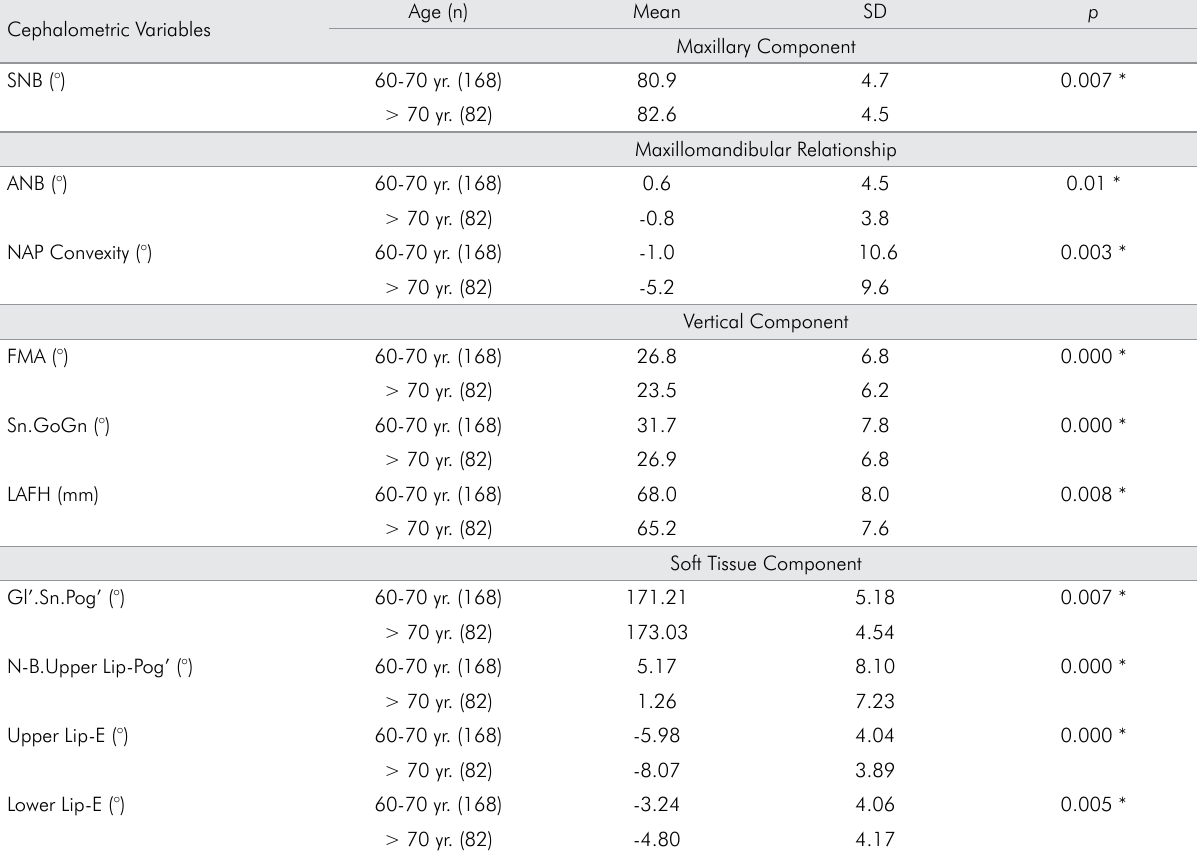
Table 4. Variables that showed significant differences as to age range: Mean, Standard Deviation (SD), independent t test ( p ). Cephalometric